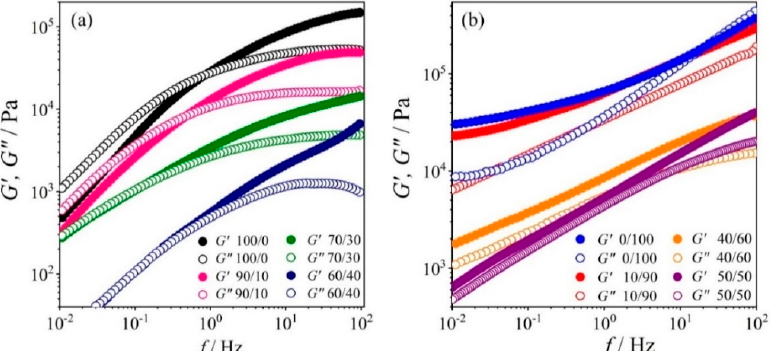
Figure 3. Plots of storage modulus (closed marker) and loss modulus (open marker) as a function of frequency for PEO/NR- g -PMMA at T = 140 °C: ( a ) blends with the excess PEO content and ( b ) blends with the excess NR- g -PMMA content. Table 2. Power law exponents of G' and G" for PEO/NR- g -PMMA blends at T = 140 °C estimated with Equation (3).